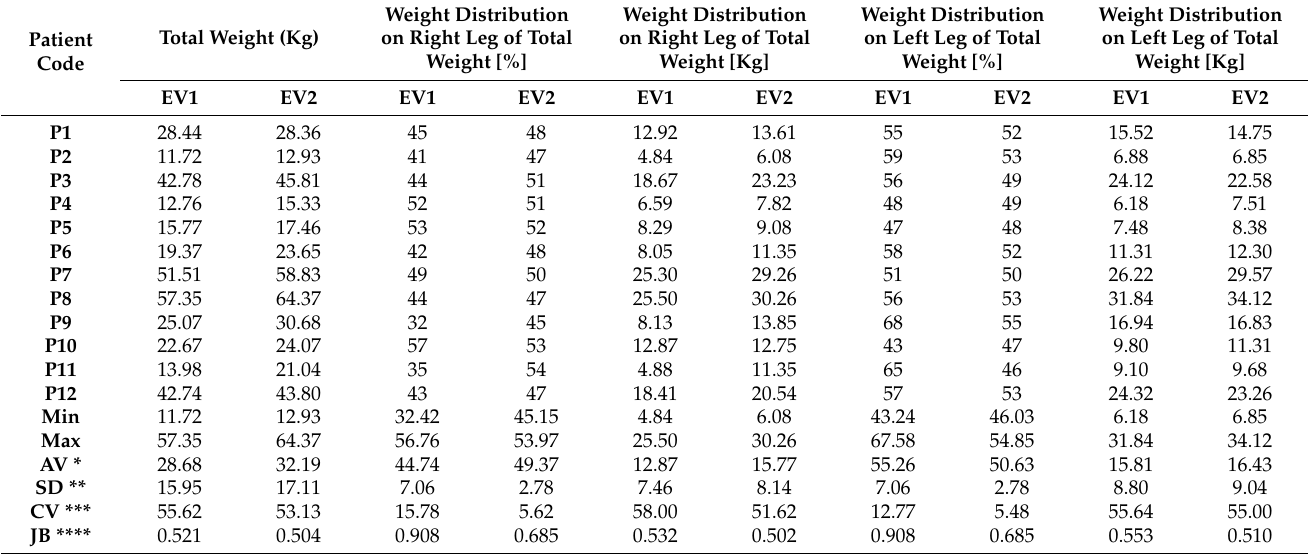
Figure 11. Evolution of GMFCS score patient P7–P12. Table 5. Weight values and their distributions on each leg, at the two